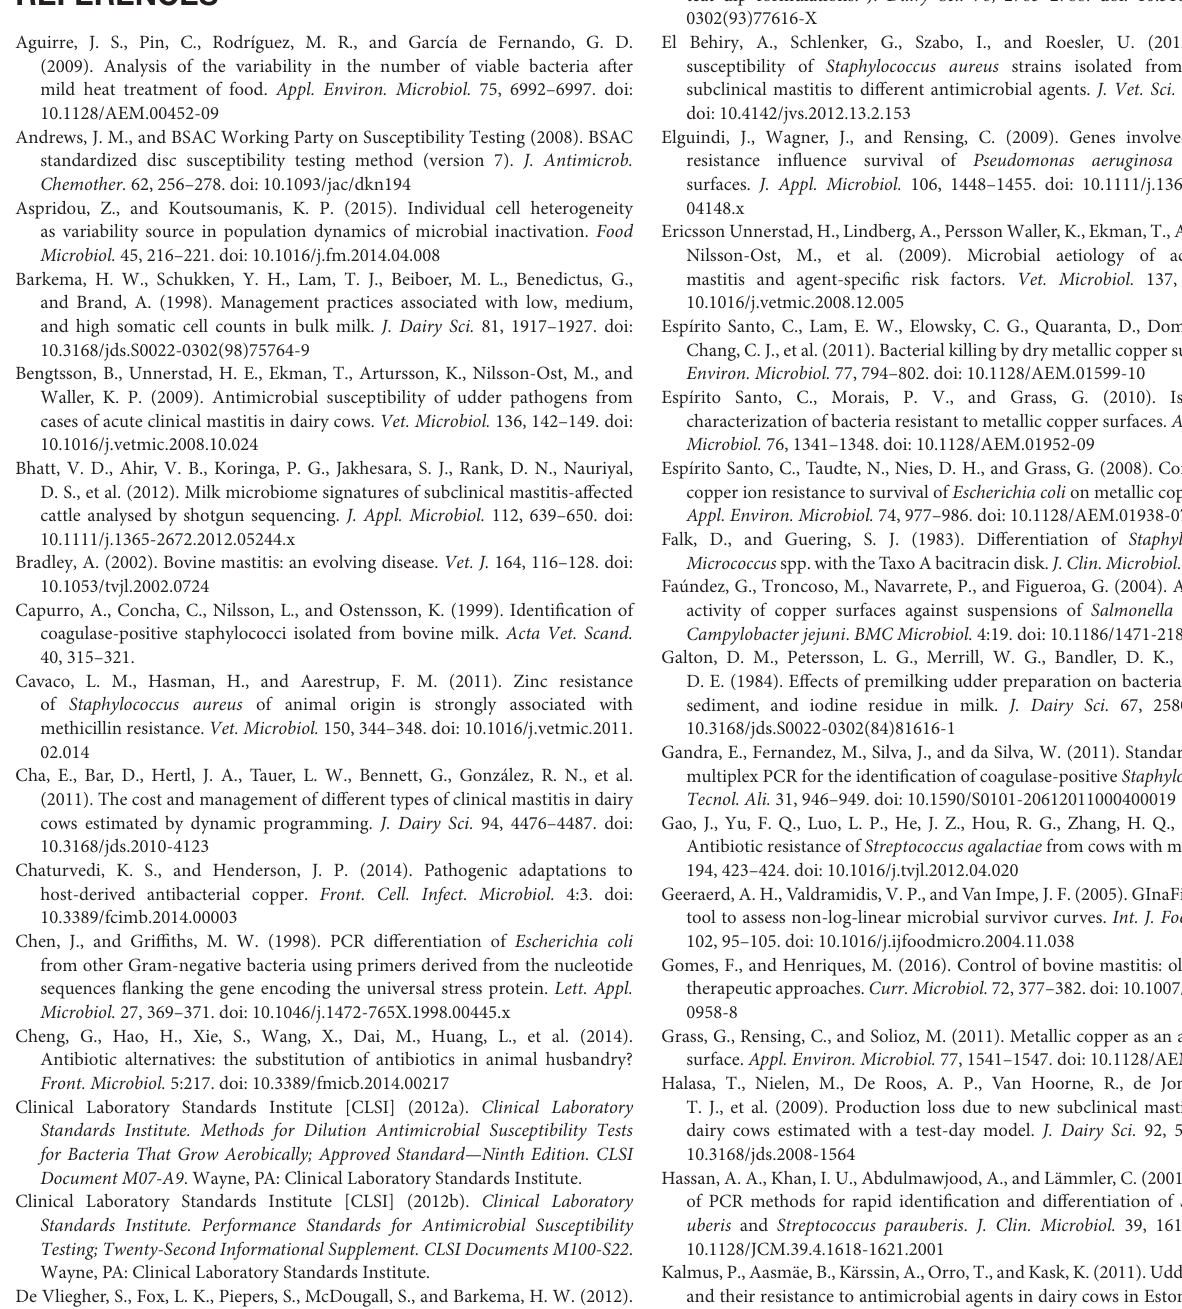
FIGURE S2 | Frequency of antimicrobial susceptibility of bacteria isolated from the central region (A, n = 41; B, n = 40) and the southern region (C, n = 157; D, n = 86) of subclinical and clinical bovine mastitis, respectively. White bars are susceptible, gray bars are intermediate and black bars resistant bacteria. Breakpoints (susceptible, intermediate, and resistant) were defined according to CLSI.